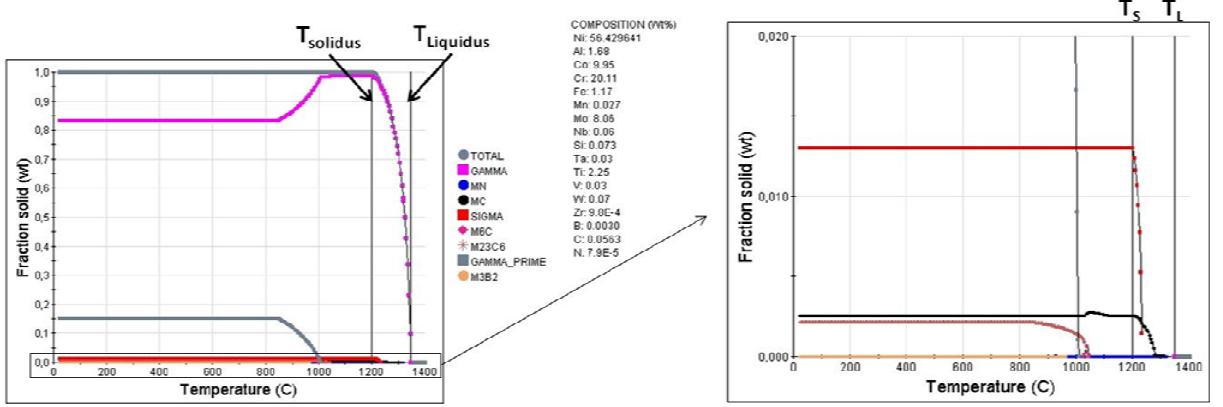
Figure 17. Calculated solidification sequence in the Haynes ® 282 ® .